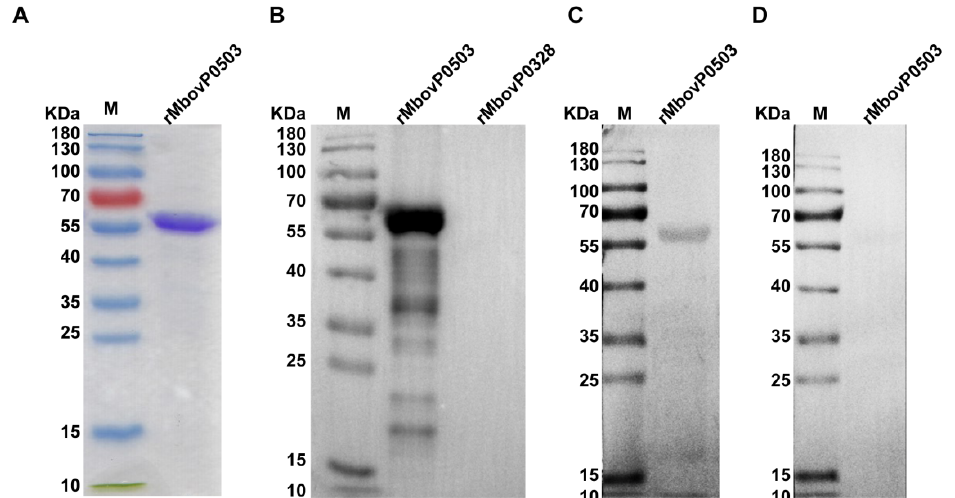
Figure 3. Immunoreactivity of rMbovP0503. ( A ) SDS-PAGE analysis of purified rMbovP0503. ( B ) Western blotting analysis of rMbovP0503 reactivity with the rMbovP0503 antiserum, ( C ) cattle antiserum against HB0801, and ( D ) negative cattle serum. The unrelated M. bovis recombinant protein rMbovP328 was used as a negative control. M: prestained protein ladder.